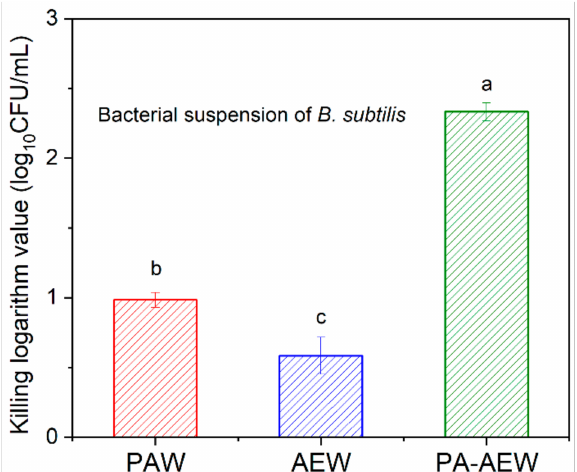
Figure 3. Sterilization effects of PAW, AEW and PA-AEW on the bacterial suspension of B. subtilis . Values with different lowercase letters above graph bars represent a significant difference ( p < 0.05).